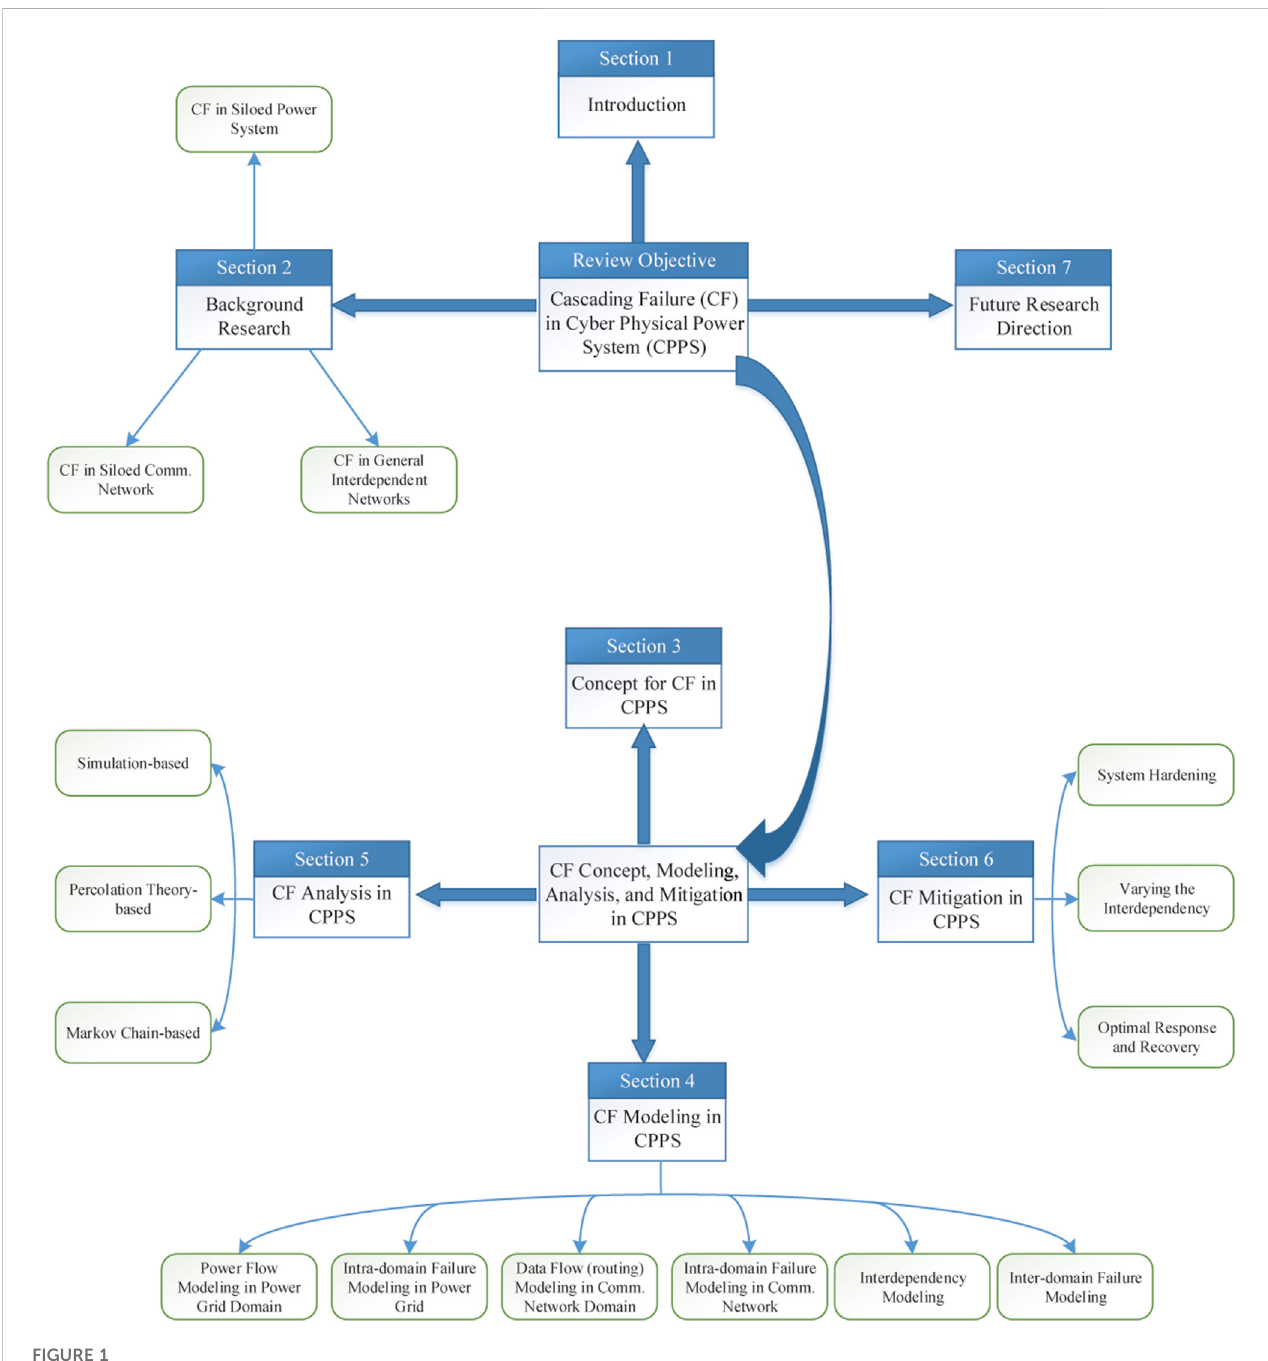
FIGURE 1 Overall structure of the review